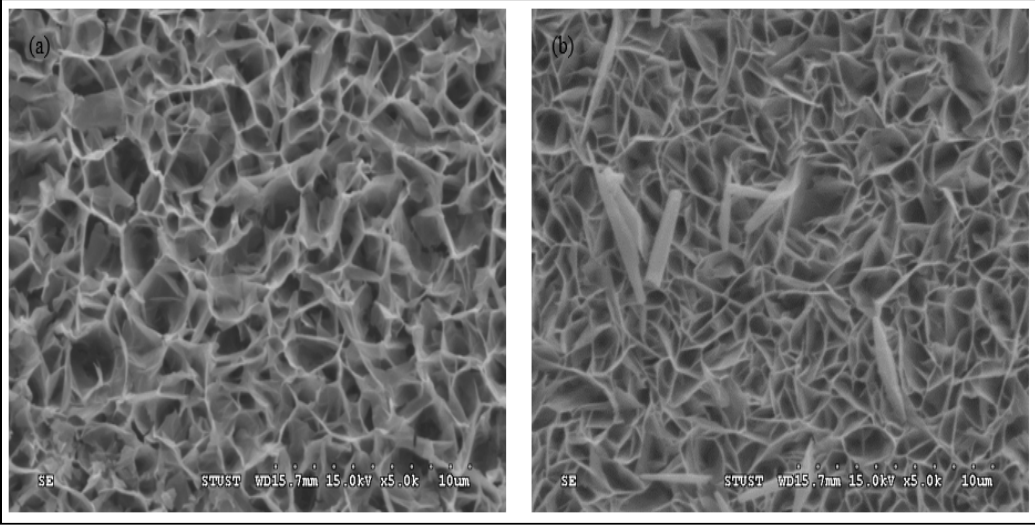
Figure 5. SEM image of ( a ) ZnO sample and ( b ) Au–ZnO sample.